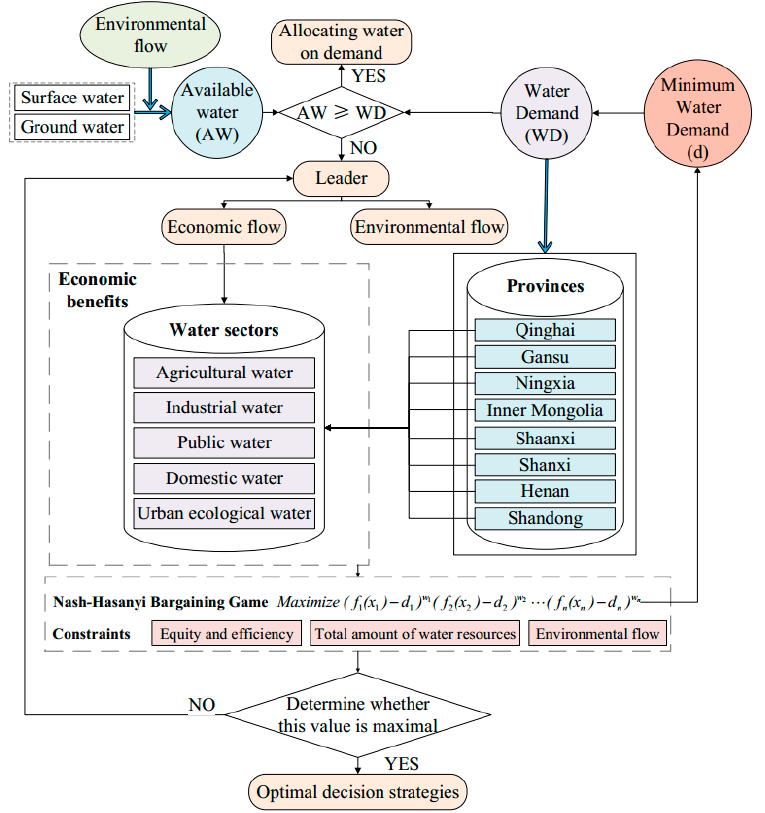
Figure 3. The framework for the design and planning of the Yellow River’s water resources alloca- tion.